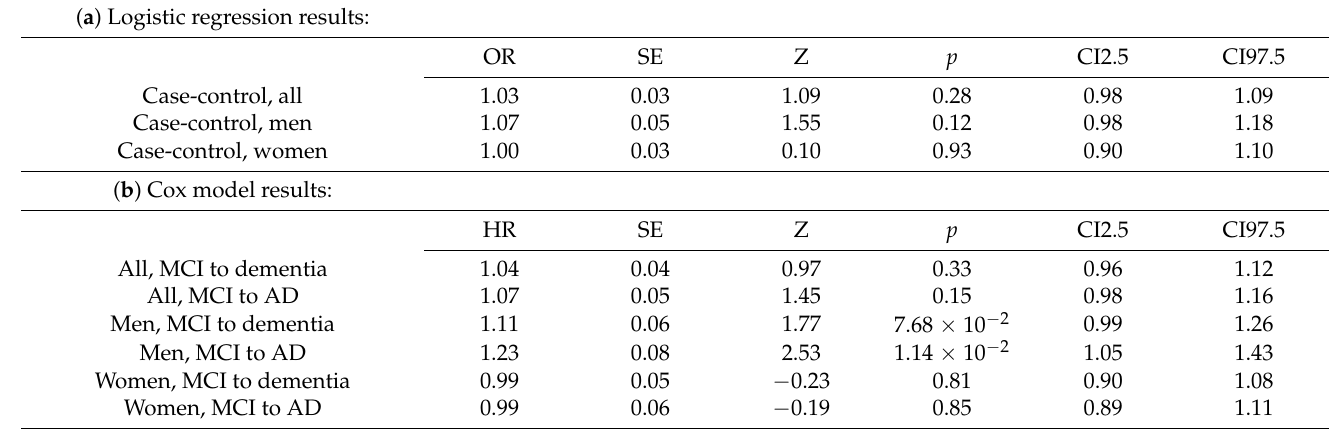
Table 3. Association results for mloy-PRS. ( a ) Results of logistic regressions for case-control AD. We only included individuals aged 65–85 years in the models. We adjusted the models by APOE genotype, age, and principal components. ( b ) Results of joint analysis of prospective MCIs in the progression from MCI to all-cause dementia or AD. We adjusted the models by APOE genotype, age, and cohort ascertainment. The 95% confidence interval is presented as the 2.5% quantile (CI2.5)